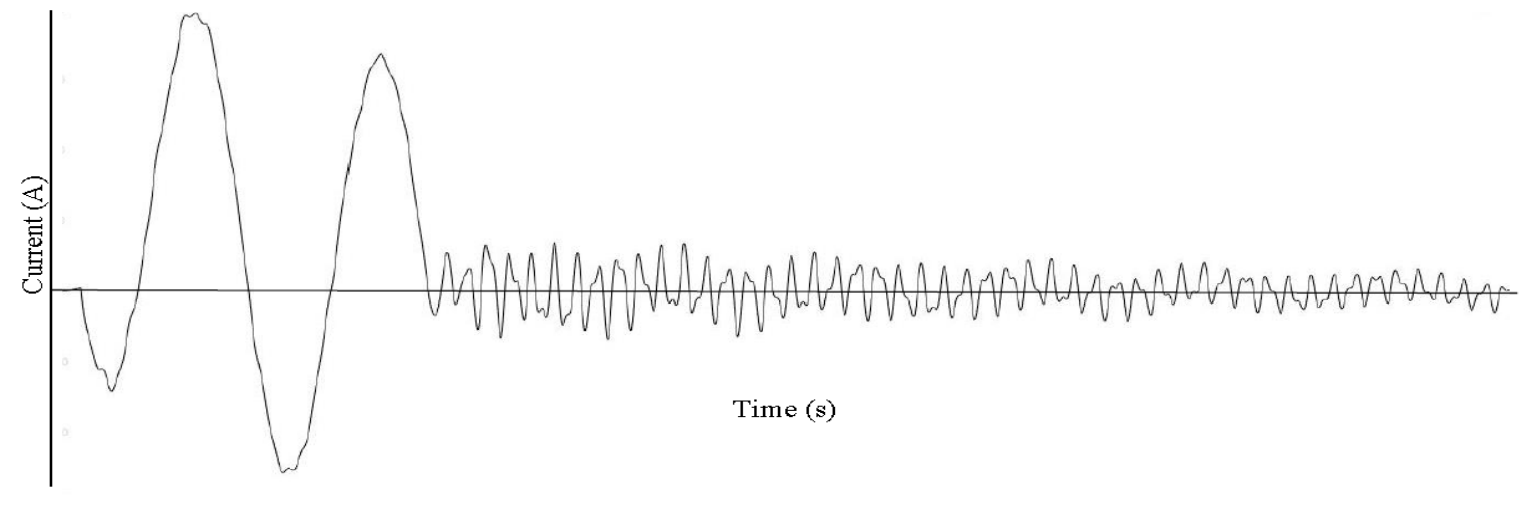
Figure 14. Normal bus capacitance.